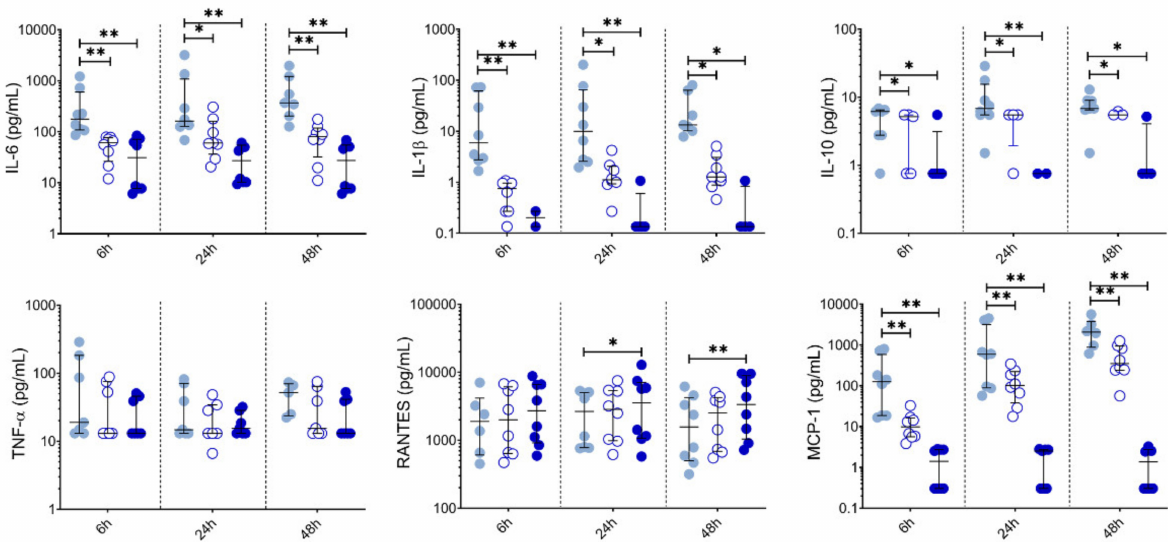
Figure 5. LSF effect on cytokine and chemokine secretion over time. Cytokine and chemokine measurements in supernatants from healthy adult PBMCs ( n = 8) following treatment with 10 µ M or 50 µ M LSF for 6 h, 24h, or 48 h. The median ± IQR are displayed. DMSO was used as a vehicle control for LSF treatments. * p < 0.05, ** p < 0.01 compared to the untreated DMSO control using a non-parametric Wilcoxon signed-rank test. Legend: • Control, 10 µ M LSF, • 50 µ M LSF, • DMSO. Abbreviation: DMSO, dimethyl sulfoxide; IL, interleukin; IQR, inter-quartile range; LSF, L-sulforaphane; MCP-1, monocyte chemoattractant protein-1; RANTES, PBMC, peripheral blood mononuclear cells; Regulated upon Activation, Normal T Cell Expressed and Presumably Secreted; TNF- α , tumour necrosis